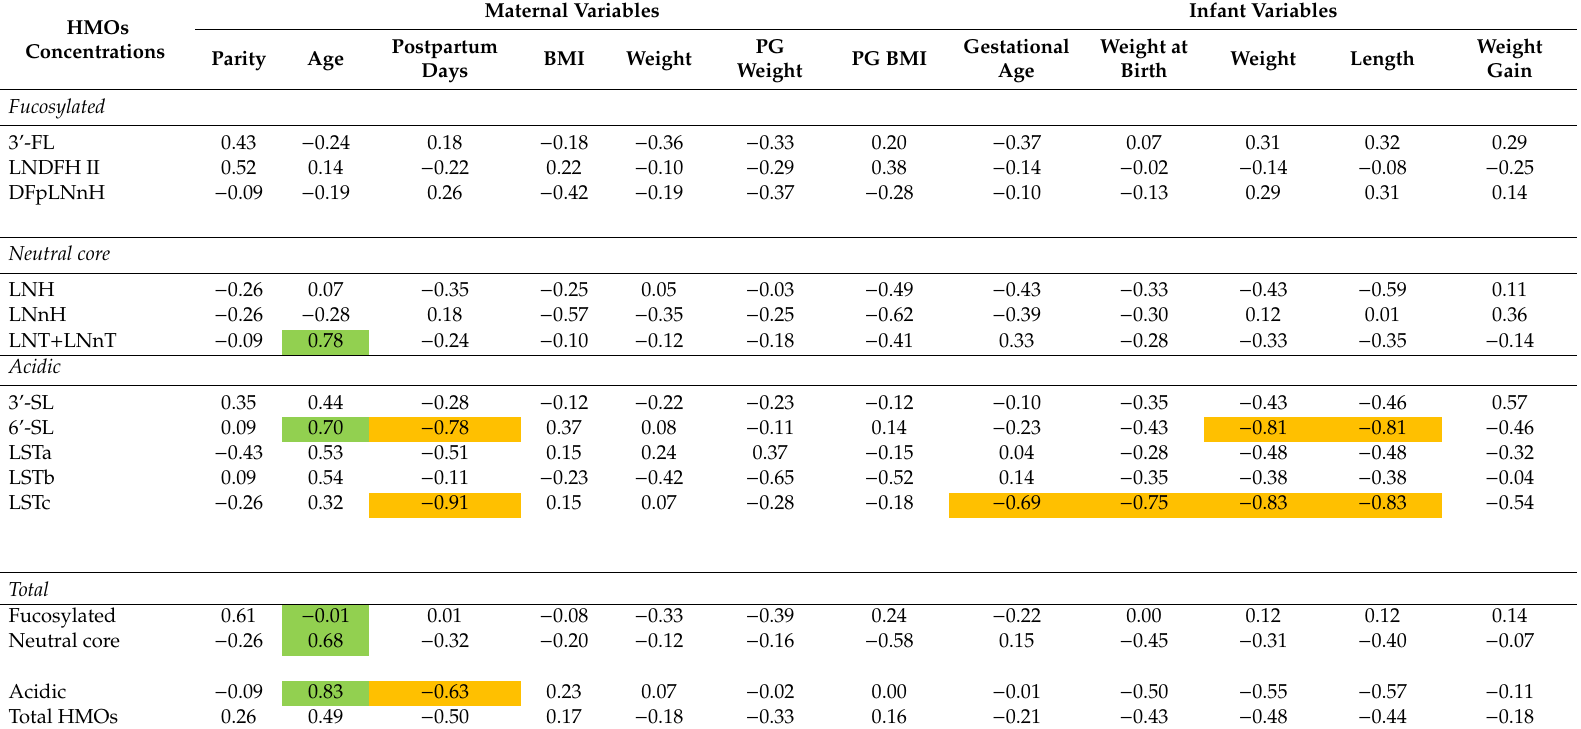
Table A4. Spearman rank correlation coe ffi cient (r) between HMOs concentrations and quantitative clinical variables in Se − women ( n = 10). Maternal Variables Infant HMOs Concentrations